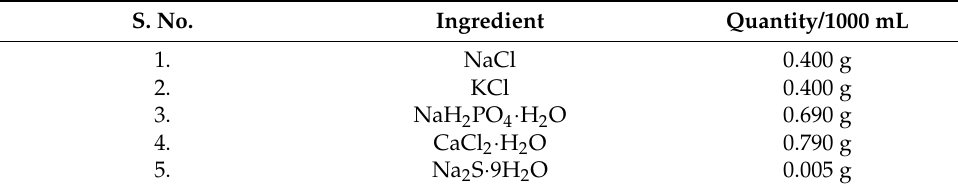
Table 2. Composition of the phosphate-rich storage solution. S. No.